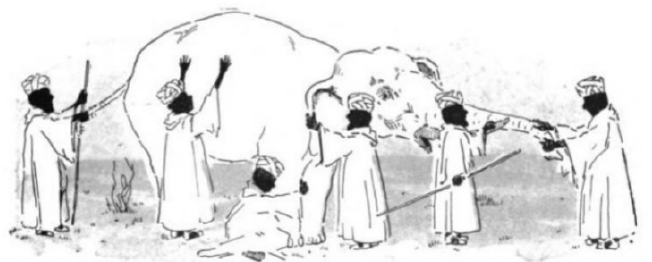
Table 2. List of the physics textbooks examined.